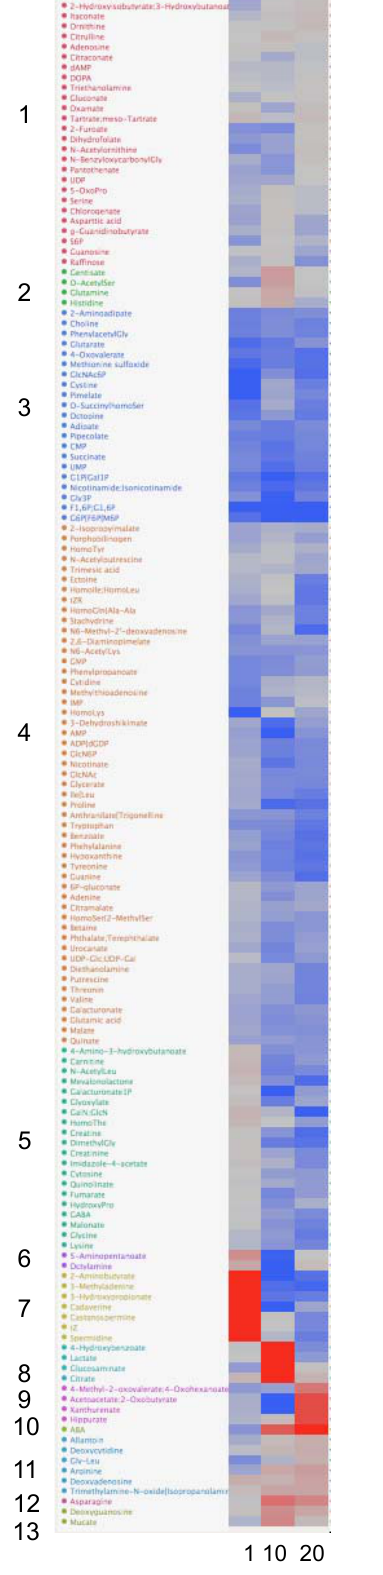
Figure 1. Clustered heat map of the P0/P8 ratios of metabolite relative peak areas for root exudates of common bean plants 1, 10 and 20 DAT. The P0/P8 ratio increased by P deficiency is shown in red and that decreased by P deficiency in